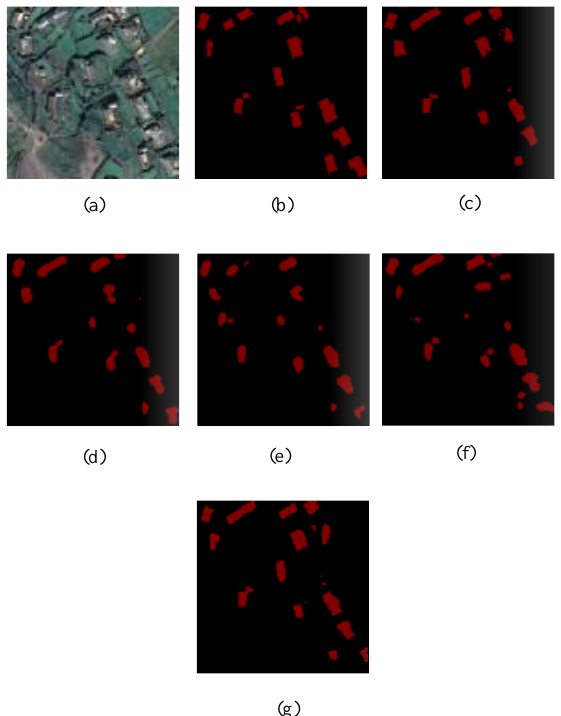
Figure 13. Comparison results results of semantic segmentation methods using Satellite dataset II (East Asia). ( a ) Input image; ( b ) ground truth; ( c ) ResNet50 + ASPP; ( d ) DeepLabV3+; ( e ) ENet; ( f ) ESPNet; ( g ) Our method (LResNet50 + WASP(AVE) +